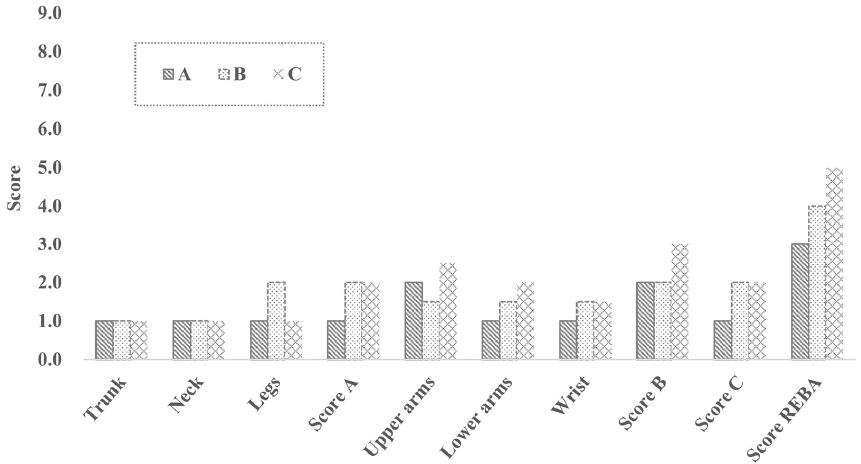
Figure 22. Precision evaluation results of circular saw working posture.